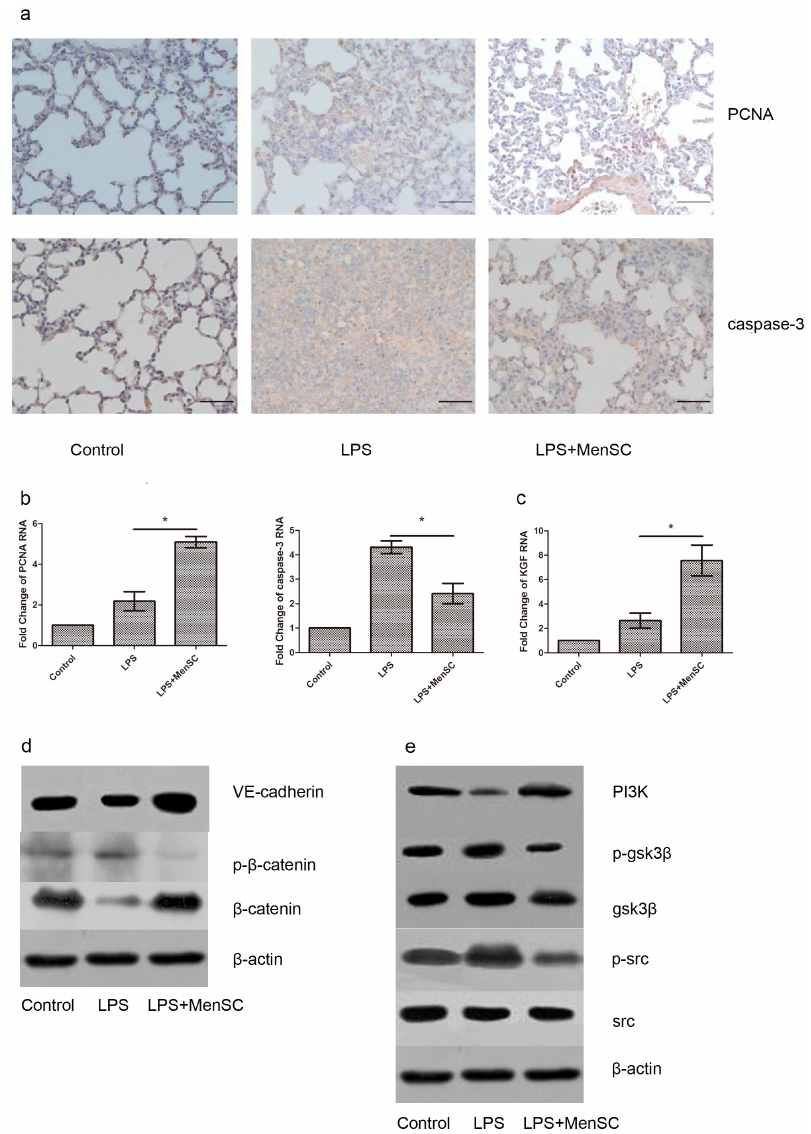
Figure 7. MenSCs promote the repair of damaged lung tissue. ( a ) Representative immunohistochemistry images for PCNA and caspase-3 of different groups; ( b ) Expression levels of PCNA and caspase-3 in the lung tissue; ( c ) KGF expression level in the lung tissue; ( d , e ) Western blot analysis of protein levels of VE-cadherin, β -catenin, p- β -catenin, Src, p-Src, PI3K, gsk3 β , p-gsk3 β and β -actin in the lung tissues of different groups * p < 0.05. Scale bar: 50 µm.